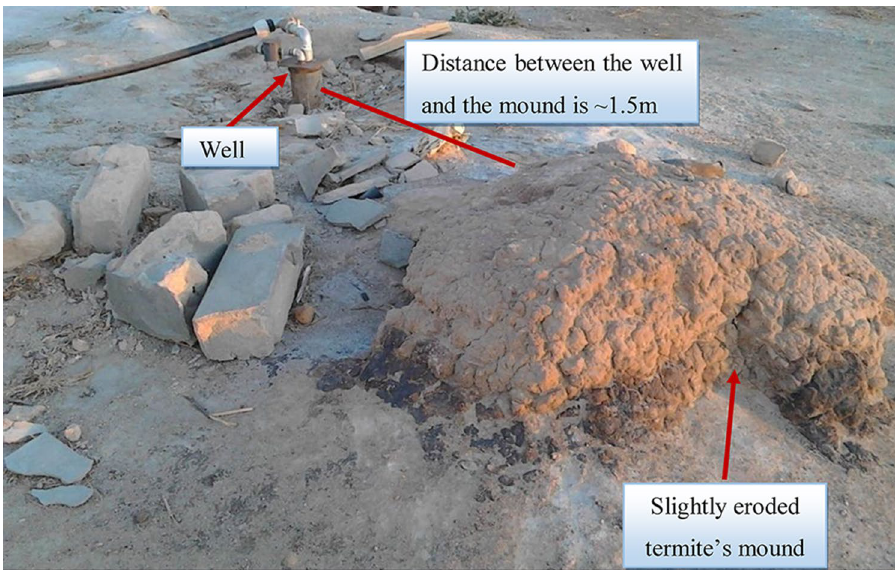
Fig. 3 Showing a 103 m deep BH drilled close to a slightly weathered termite’s mound, at Nzuguni, suburb. Notice that the BH is ~ 1.5 m from the